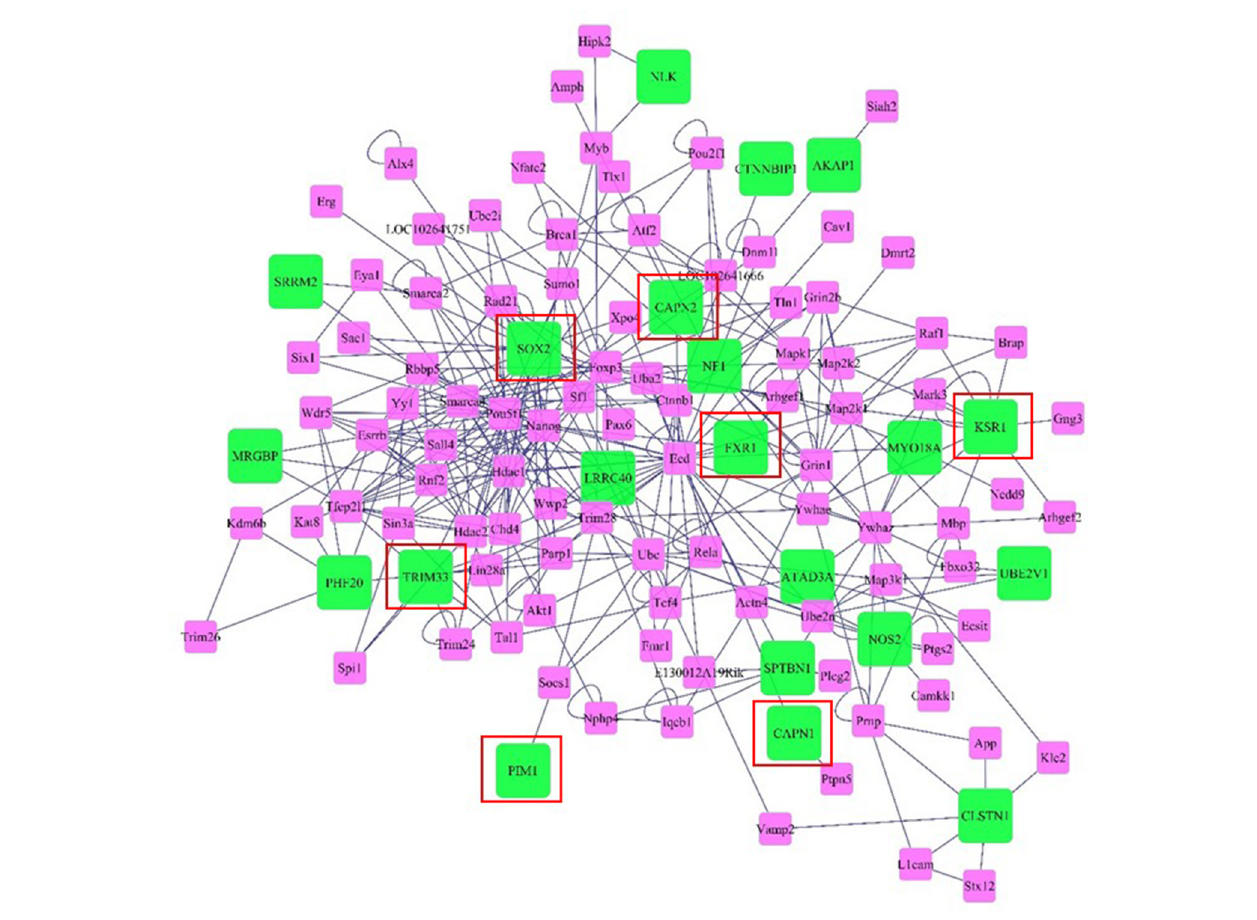
FIGURE 6 | Network of genes and neighboring genes in the same scaffold as the SNPs identified in the wssGWAS in windows responsible for ∼ 1.0% or more of the total genetic variance of the analyzed traits. Green nodes denote genes and near genes detected by the wssGWAS analysis and pink nodes denote connecting neighbors. Edges denote known relationships between genes in the SysBiomics repository. Framed genes (red square) are discussed in the